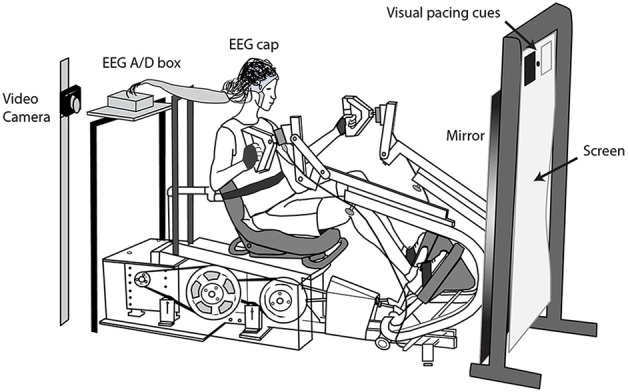
Experimental setup. Subjects moved to the pace of visual cues with (1) both their arms and legs, (2) their legs only, and (3) their arms only. A video camera to the left on the subject's head recorded videos of the subject exercising, as viewed in the mirror, for the three active conditions. For the viewed conditions, we removed the mirror, and projected life-size video playbacks of the subject or another individual exercising. The subjects remained seated in the stepping device during the viewed conditions. We recorded EEG during all conditions.